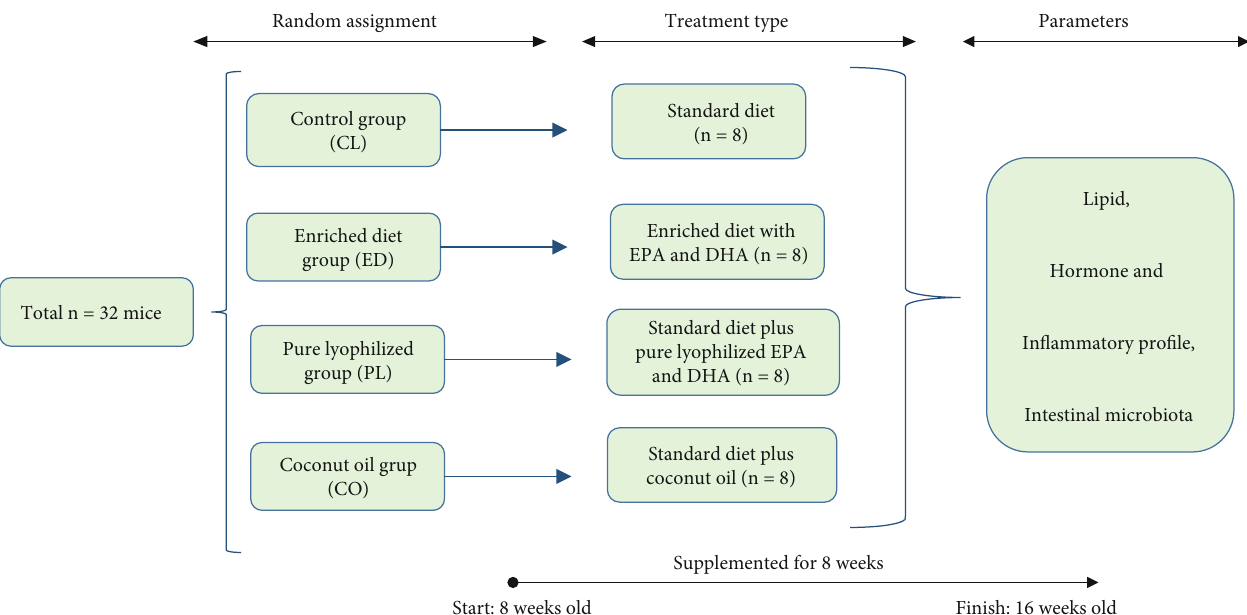
Figure 1: Distribution of study groups, based on strain type, form, and timeline of supplementation administered. Study groups: control group (CLG), enriched diet group (EDG), lyophilized group (LG), and coconut oil group